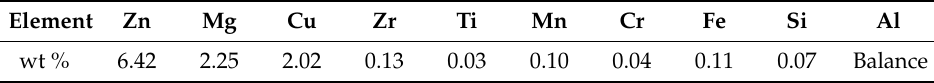
Table 1. Chemical compositions of 7050 aluminum alloy.